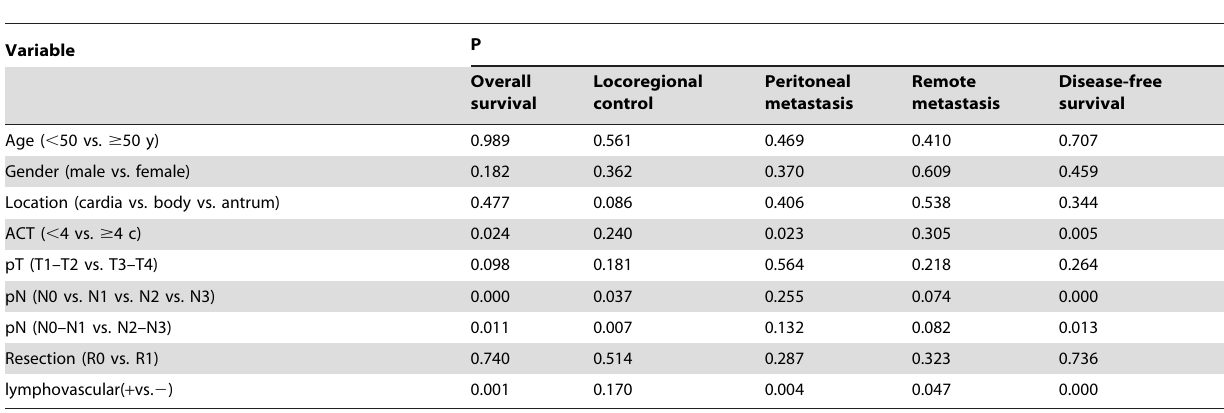
Table 2. Univariate analyses of overall survival, local control, and disease-free survival.